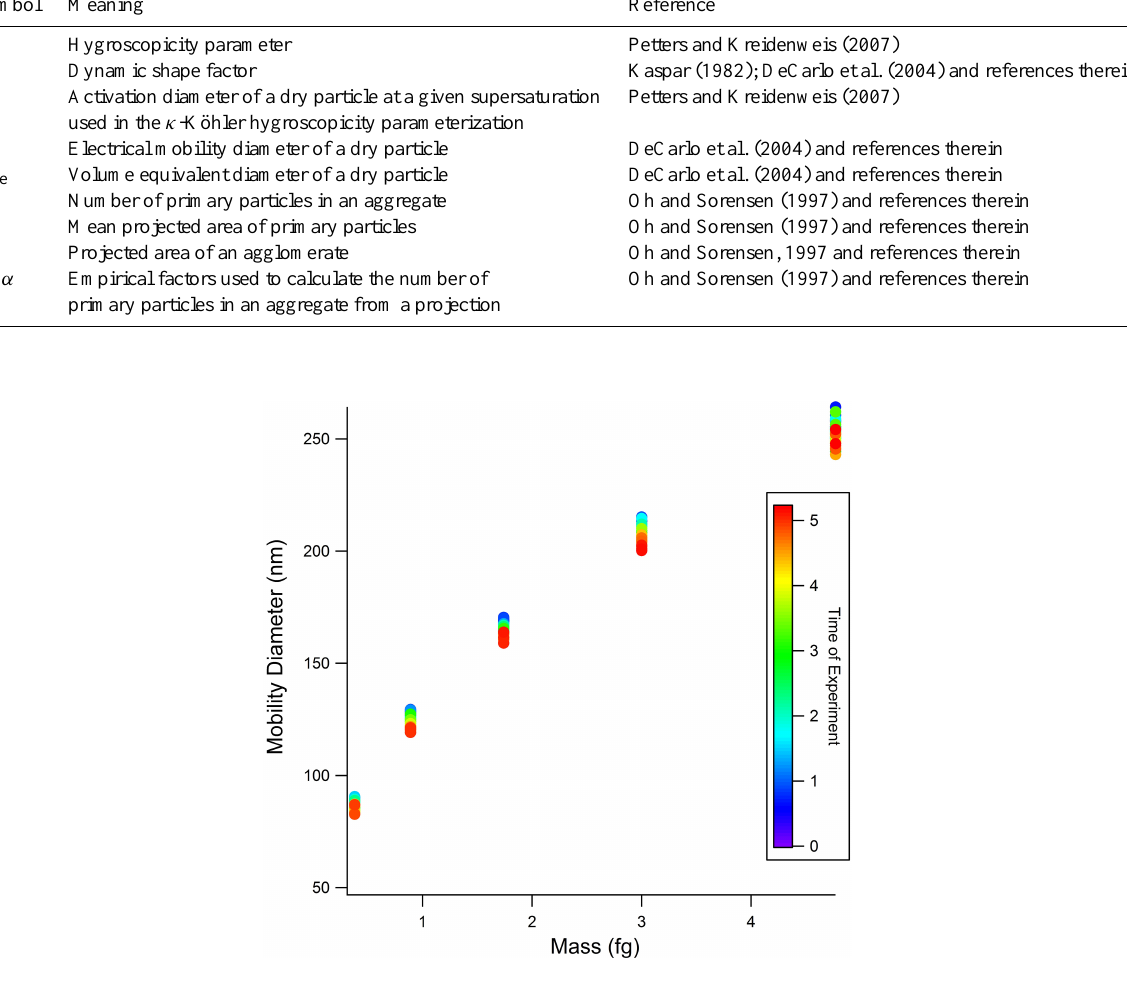
Figure A1. Raw APM–SMPS data for one chamise experiment shown in the paper. The mobility diameter for a number of selected particle masses is shown with plot markers colored as a function of experiment time. Lights are turned on at time = 1. Decreasing measured mobility diameter for a given particle mass indicates that particles are becoming less fractal with